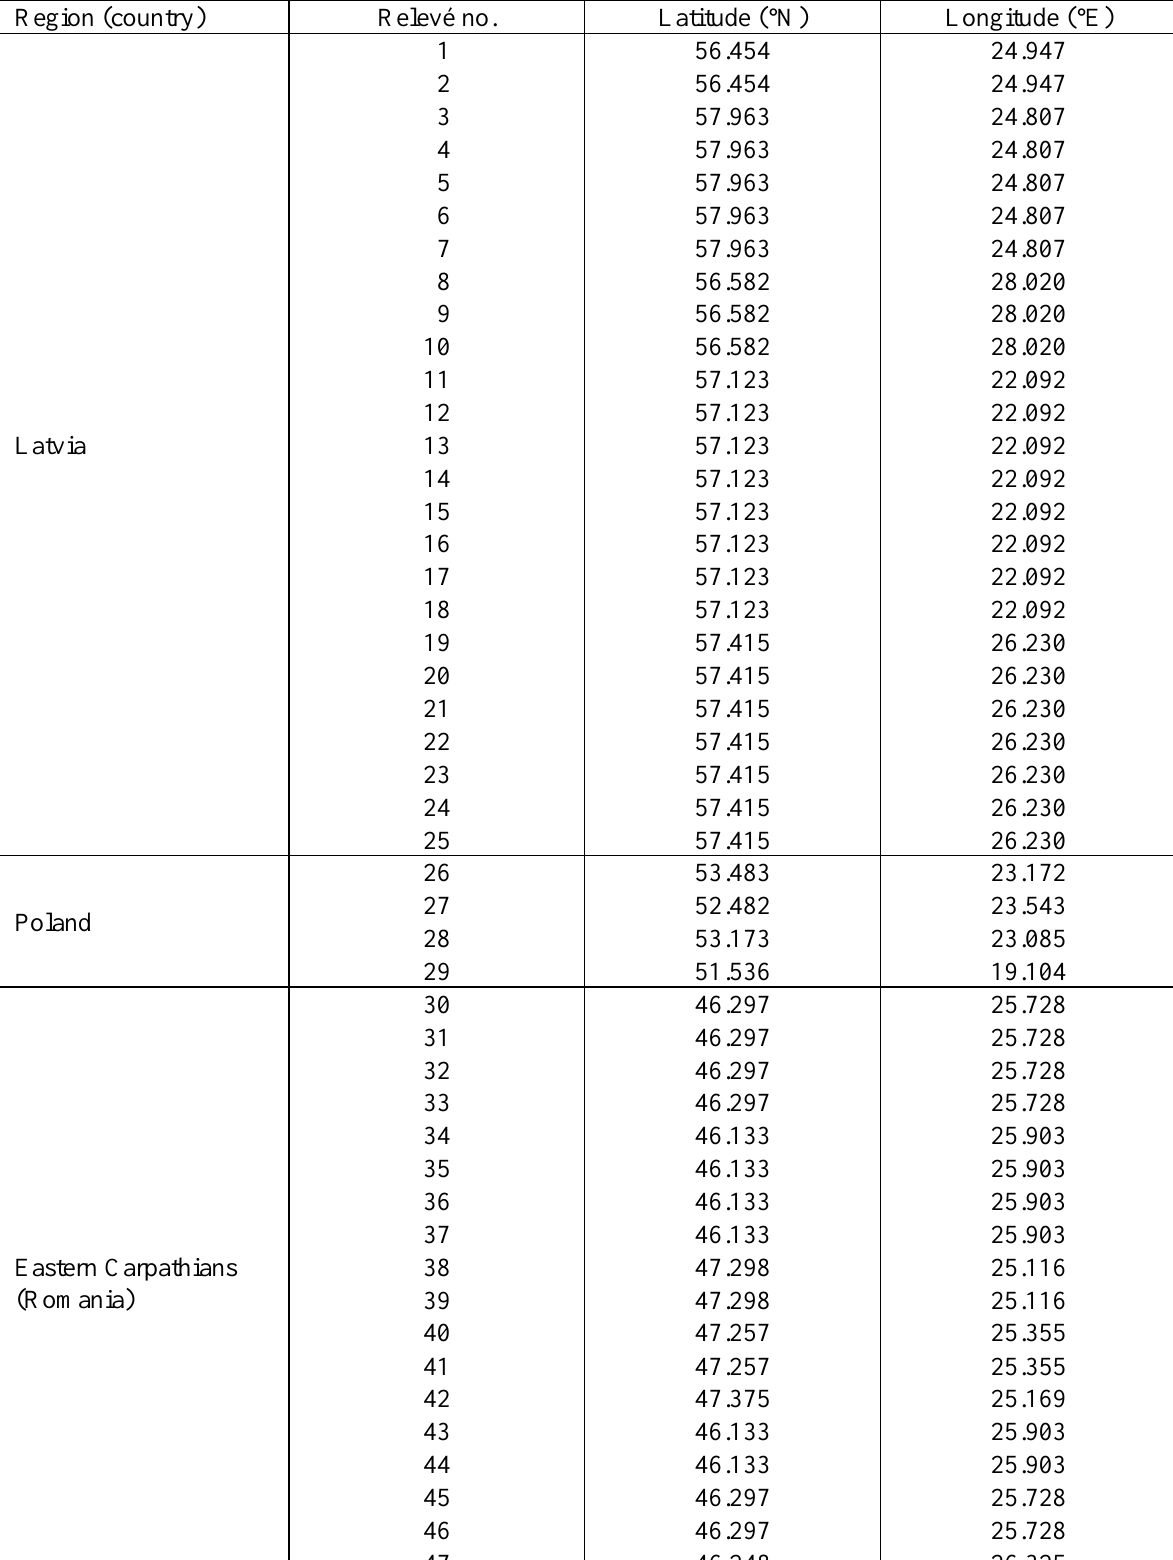
Table A2. Geographic coordinates (in decimal degrees) of the relevés by region (country). All coordinates were roughly determined based on the toponyms (locality names) declared in the original publications (Coldea & Kovács 1969, Coldea & Plămadă 1989, Woziwoda 1998, Czerepko 2011), except for those located in Latvia that were reported explicitly by the author (Prieditis